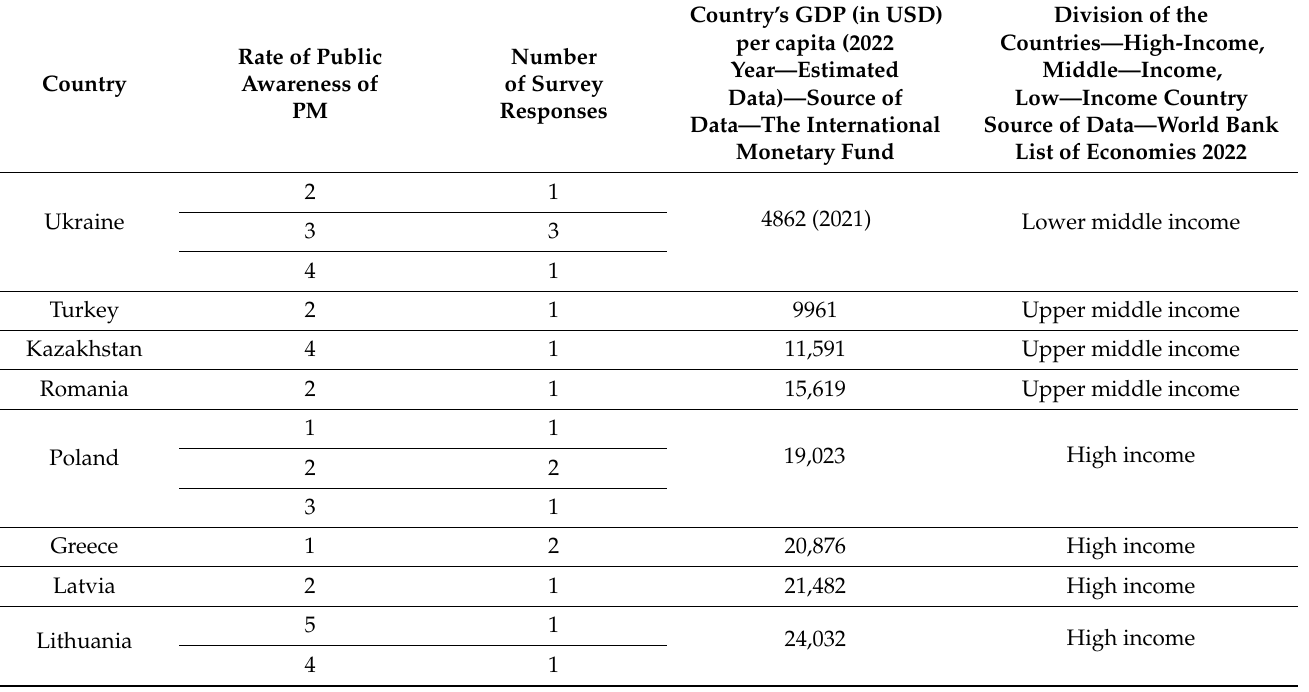
Table 1. Comparison of the public awareness of PM in a particular country of respondents and their country’s GDP per